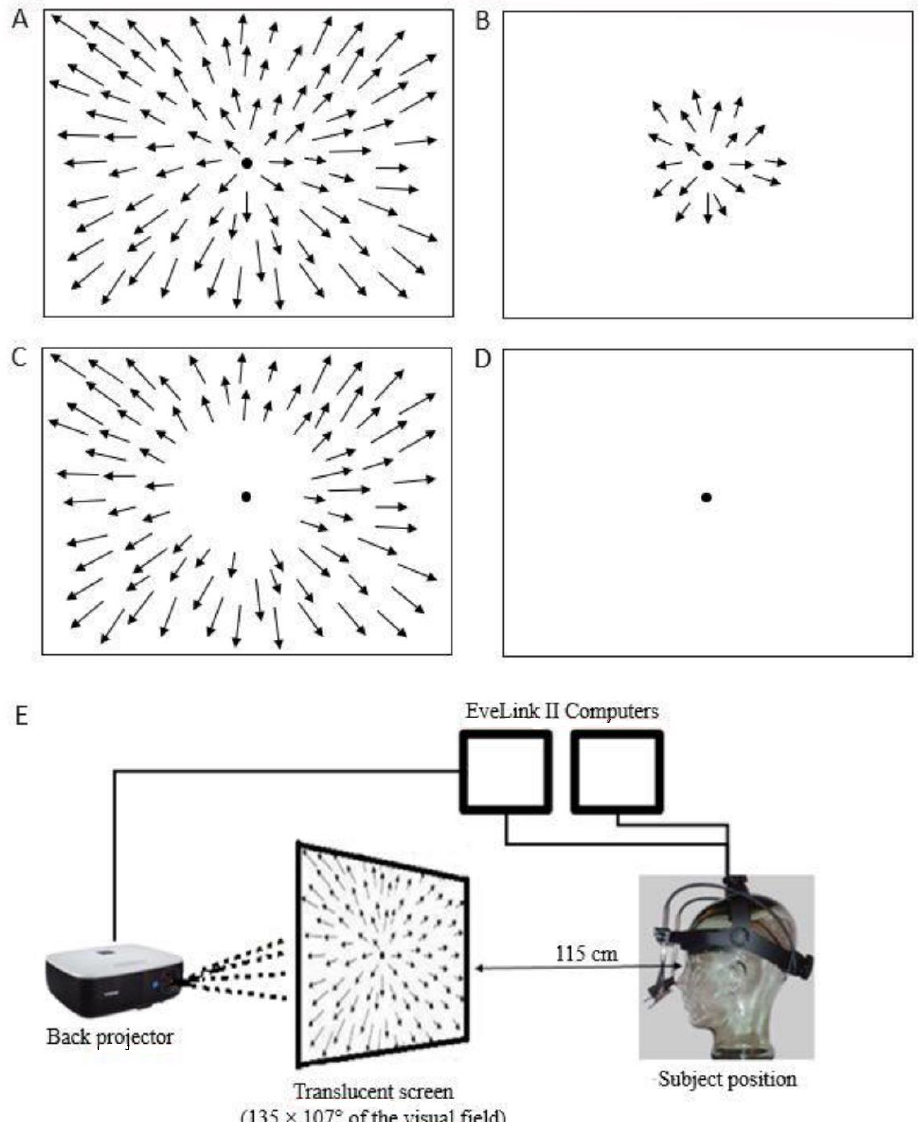
Figure 1. Optic flow and control stimuli. ( A ) Full field stimulation. ( B ) Foveal stimulation. ( C ) Pe- ripheral stimulation. ( D ) Baseline condition (control). ( E ) Illustration of the experimental setup. Full, foveal, and peripheral stimuli were presented at different speeds: 8°/s, 11°/s, 14°/s, 17°/s, 20°/s. Arrows represent the velocity vectors of moving dots.